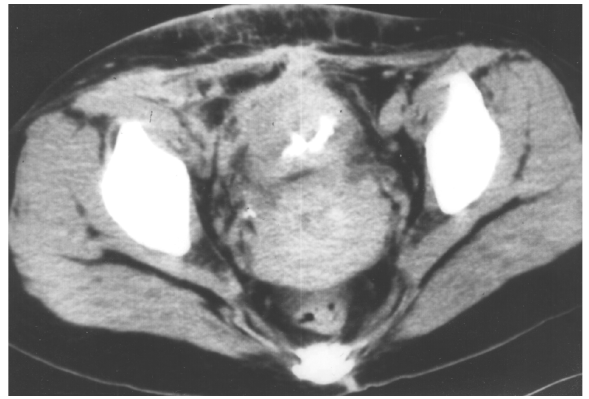
Figure 1 – Computed tomography (CT) showing a predominantly right-sided mass involving the anterior abdominal wall, small bowel and dome of the bladder.